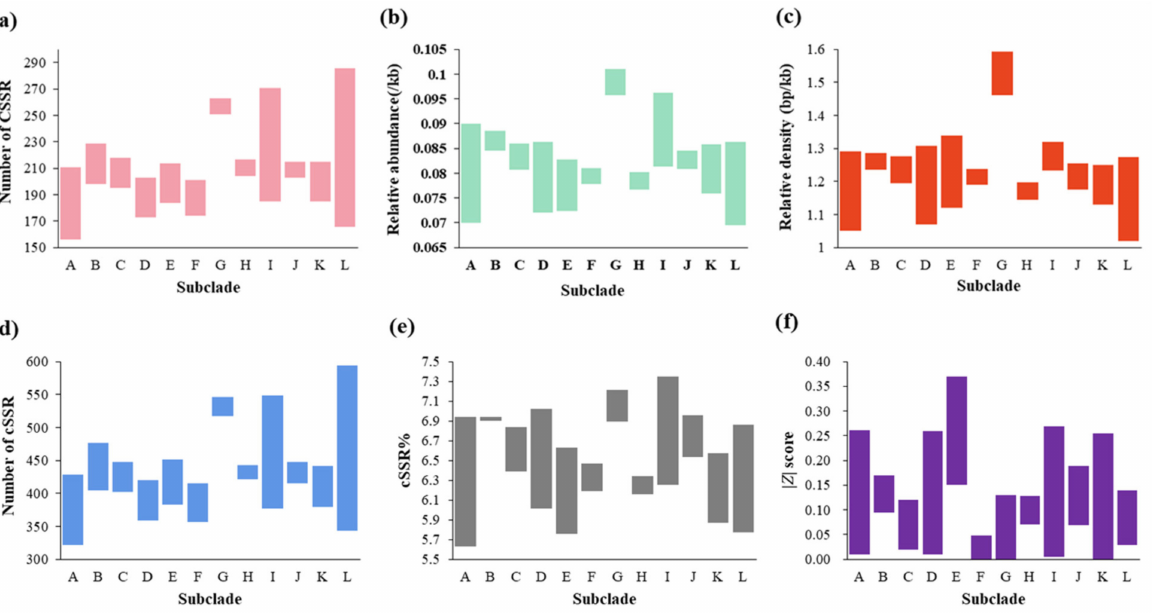
Figure 3. Number ( a ), relative abundance ( b ), and relative density ( c ) of CSSRs in genomes of 54 Parasynechococcus -like strains; ( d ) number of cSSR in each genome; ( e ) cSSR% = ncSSR/nSSR, percent- age of individual SSRs being part of CSSRs; ( f ) |Z|, statistical significance of CSSR representation. Data were presented by the subclades (A–L) identified in Figure